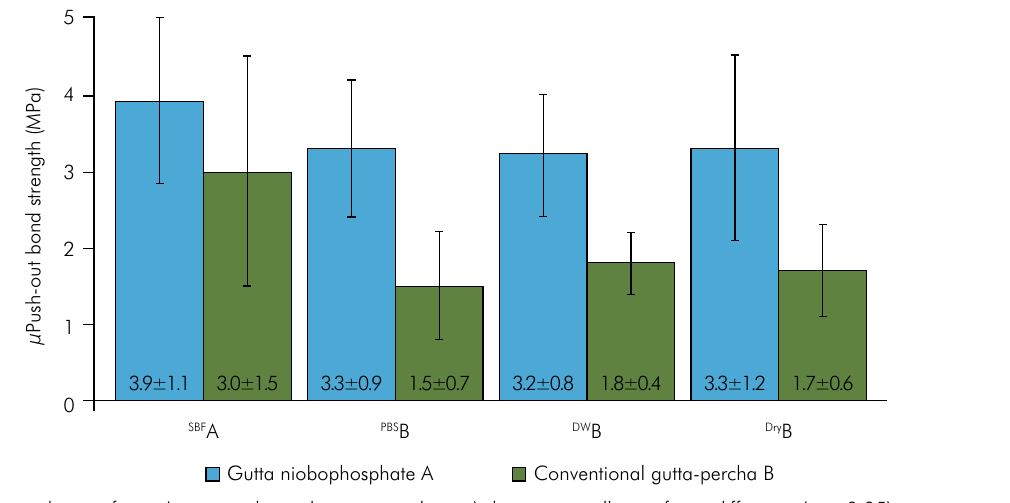
Figure 1. Mean bond strength (MPa) values for the evaluated gutta-percha and rewetting